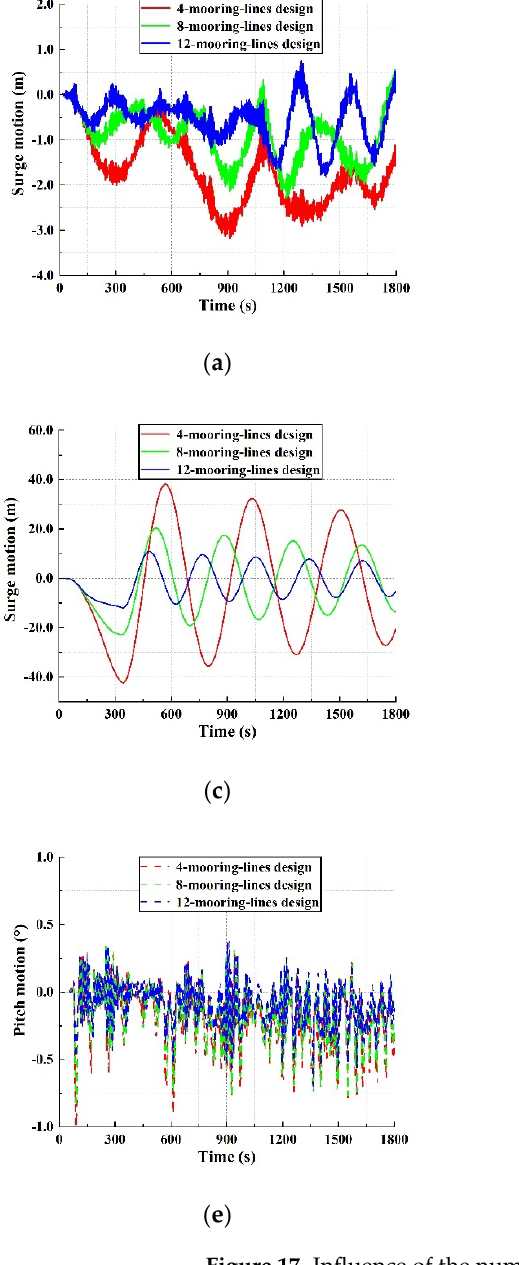
Figure 17. Influence of the number of mooring lines on Kulluk platform motion. ( a ) Surge motion under wave loads; ( b ) surge motion under level ice loads; ( c ) surge motion under broken ice floes loads; ( d ) pitch motion under wave loads; ( e ) pitch motion under level ice loads; ( f ) pitch motion under broken ice floes loads.